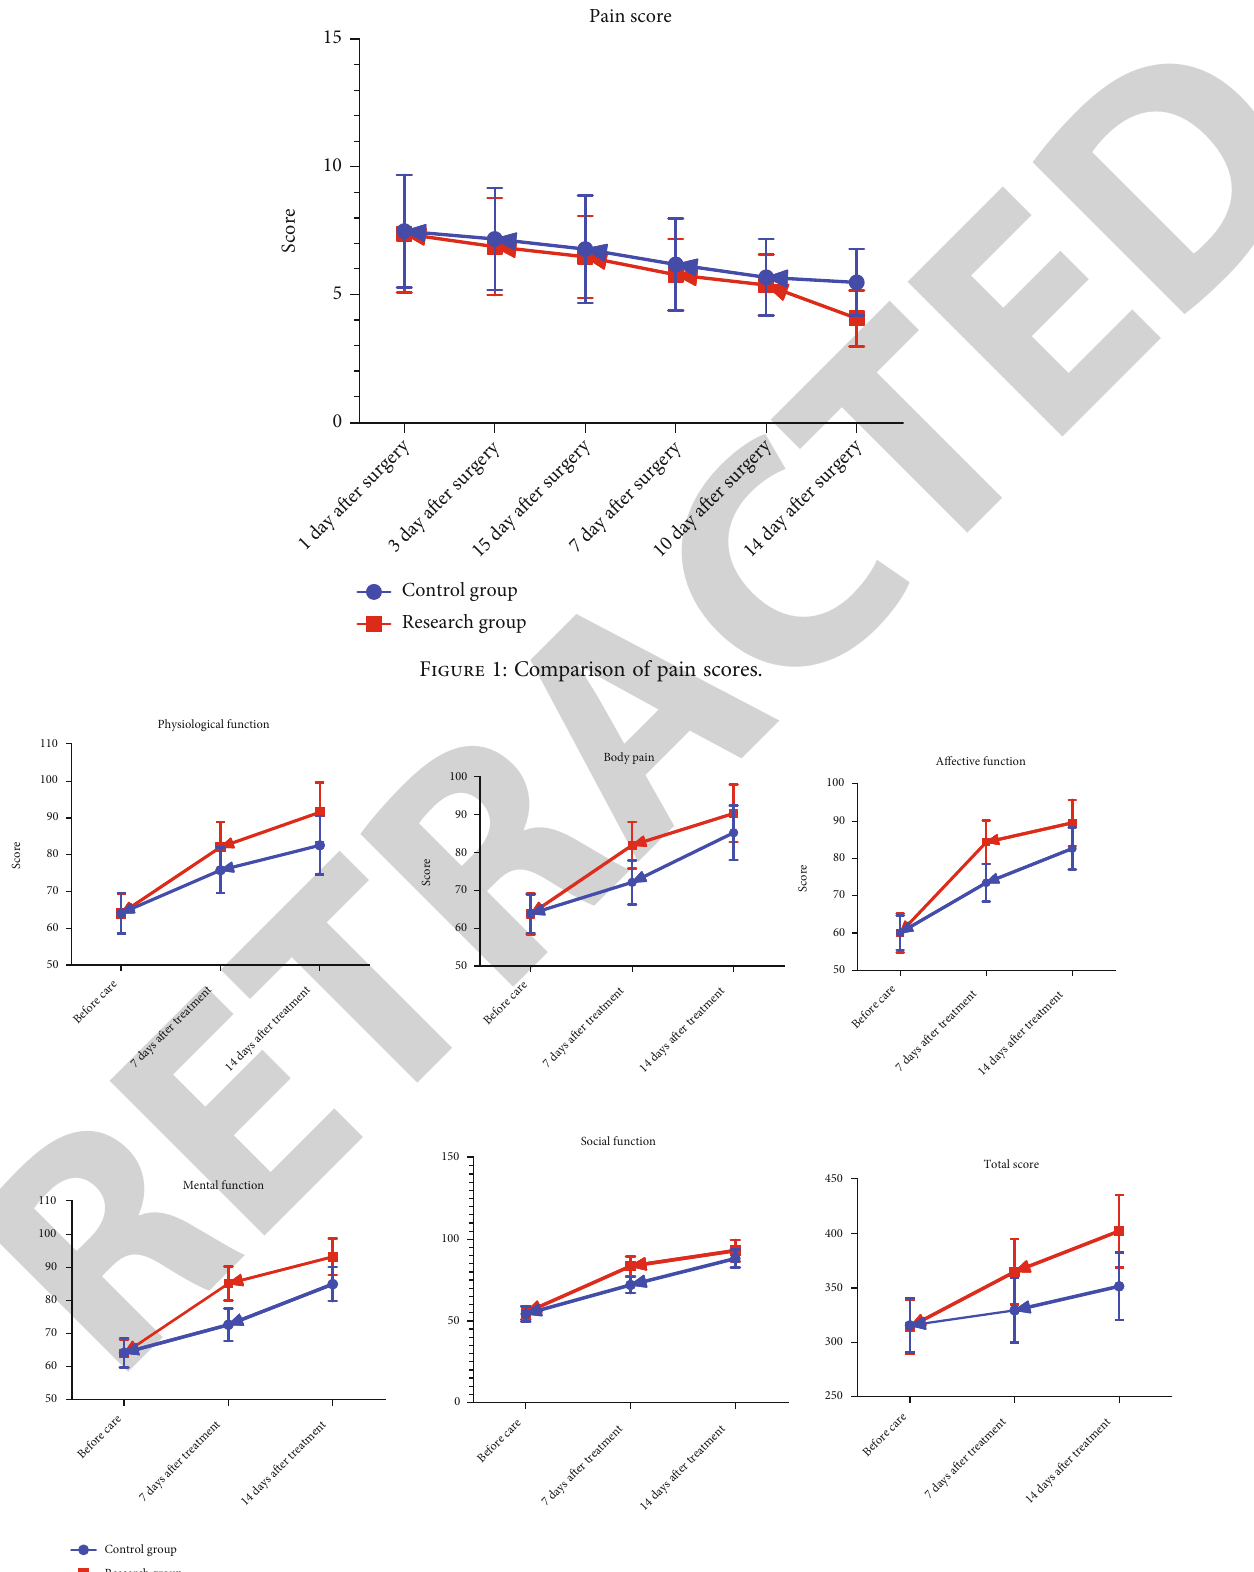
Figure 2: Comparison of quality of life score in two groups.